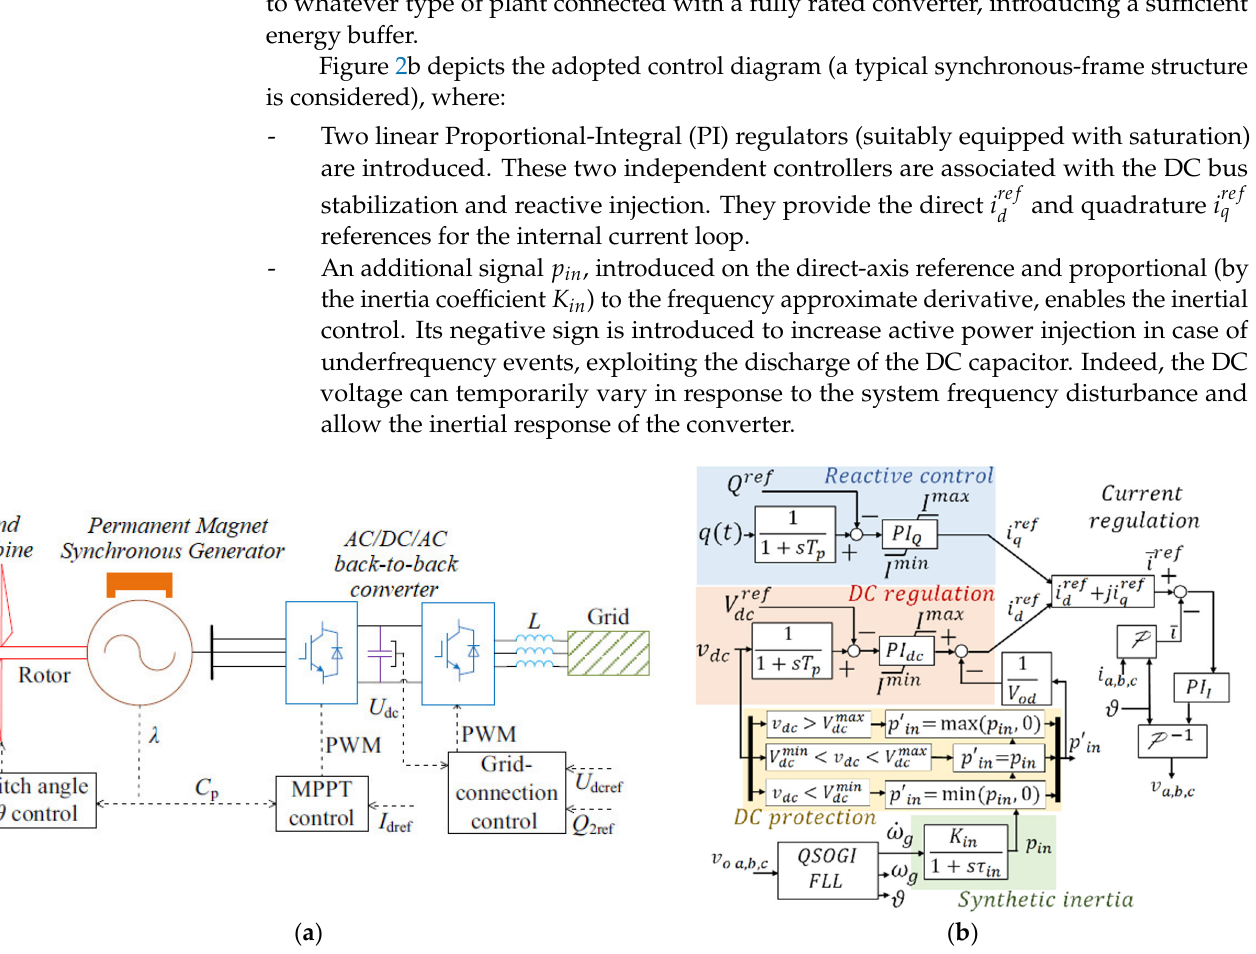
Figure 2. Full-converted wind turbine model [43] ( a ), and current controlled model for SI [6,7] ( b ). In order to extract the angular frequency derivative ̇ ω g , the QSOGI-FLL (Quadrature Second-Order Generalized Integrator—Frequency Locked Loop) algorithm is adopted [44]. The QSOGI-FLL system is also exploited to determine the synchronization angle for